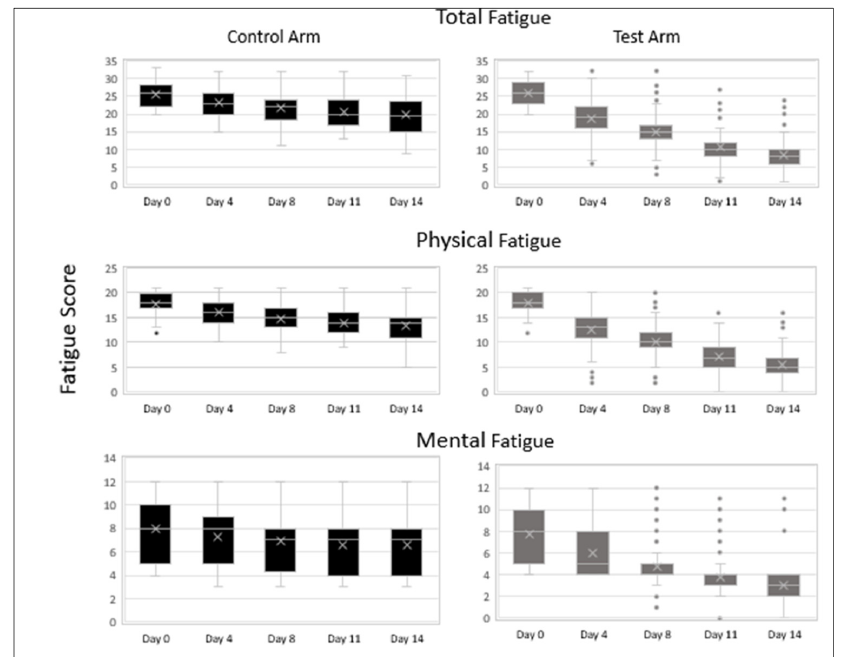
Figure 3. CFQ-11 Fatigue scores (total fatigue, physical fatigue and mental fatigue) of subjects in the control and test arms at various timepoints during the treatment period. Data are represented as median (the line dividing the box), mean (marked with an X), interquartile range (box), range (whisker) and outliers (dots). ( n = 100). (whisker) and outliers (dots). ( n =